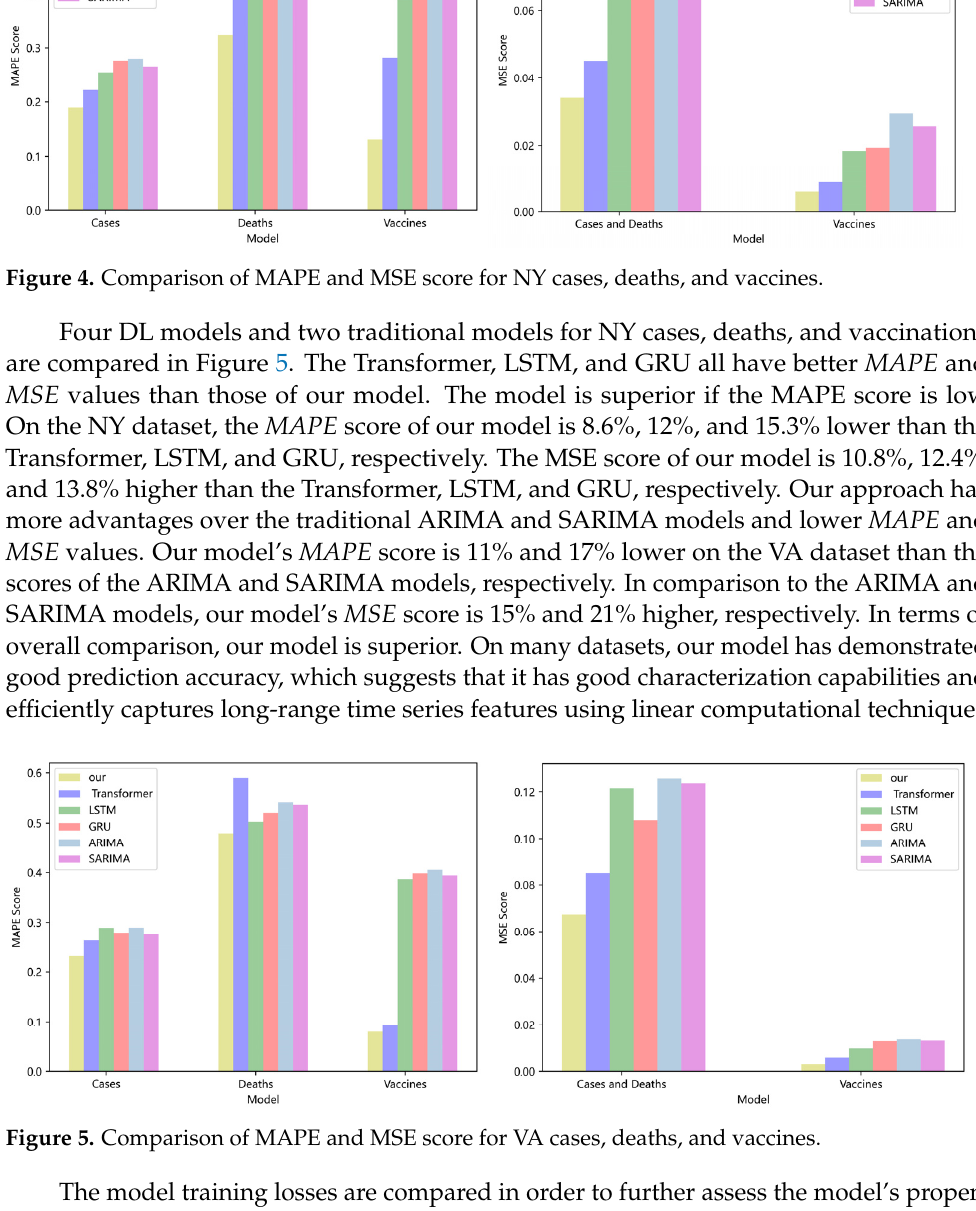
Figure 3. Comparison of MAPE and MSE score for CA cases, deaths, and vaccines.